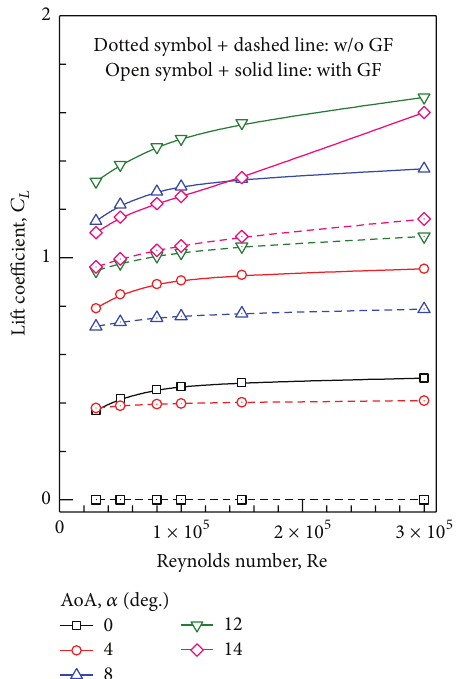
Figure 5: Variation of 𝐶 𝐷 with AoA for different Reynolds numbers for the airfoil without and with